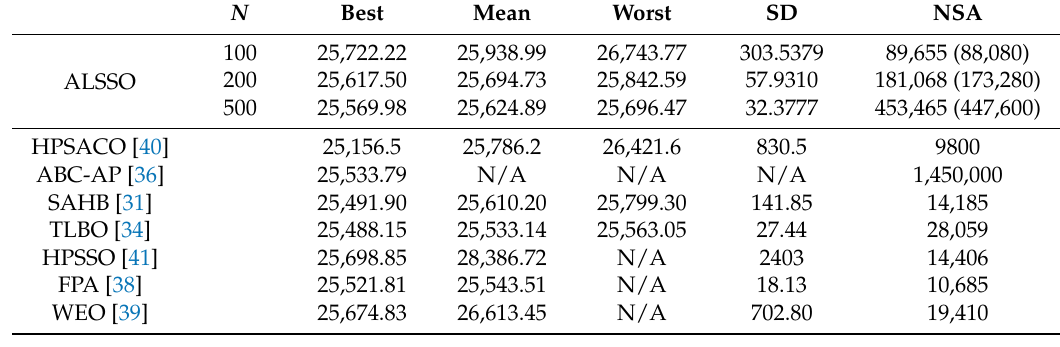
Table 11. Comparison of statistical performance in the 200-bar truss problem.